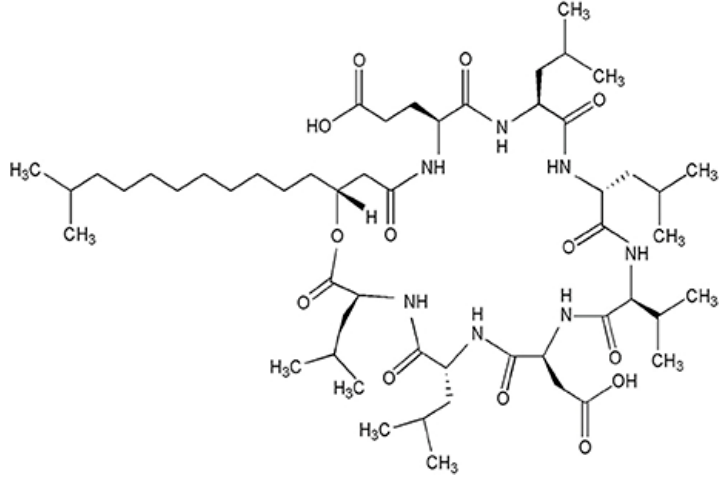
Figure 1. Chemical structure of surfactin-C 15 . Seven amino acids are arranged in the cyclic ring connected with a β -hydroxyl fatty acid with a chain length of fifteen carbon atoms to form a cyclic lactone ring.